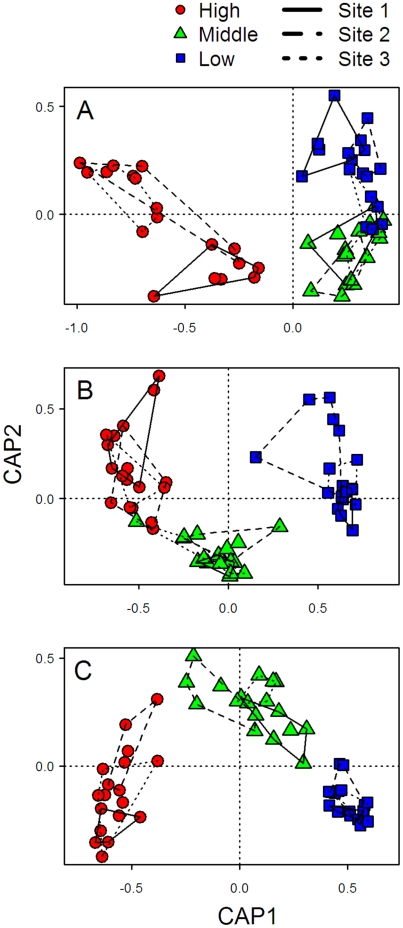
Canonical analysis of principal coordinates (CAP) ordinations showing the axes that best discriminate species assemblages at the 3 intertidal elevations surveyed on the 3 study shores: (A) Bunker, (B) Kringel, and (C) Nord-Ost-Hafen.The first and second canonical axes explained 63% and 14% of the total variation, respectively, in Bunker, 56% and 18% respectively in Kringel, and 62% and 16% respectively in Nord-Ost-Hafen.